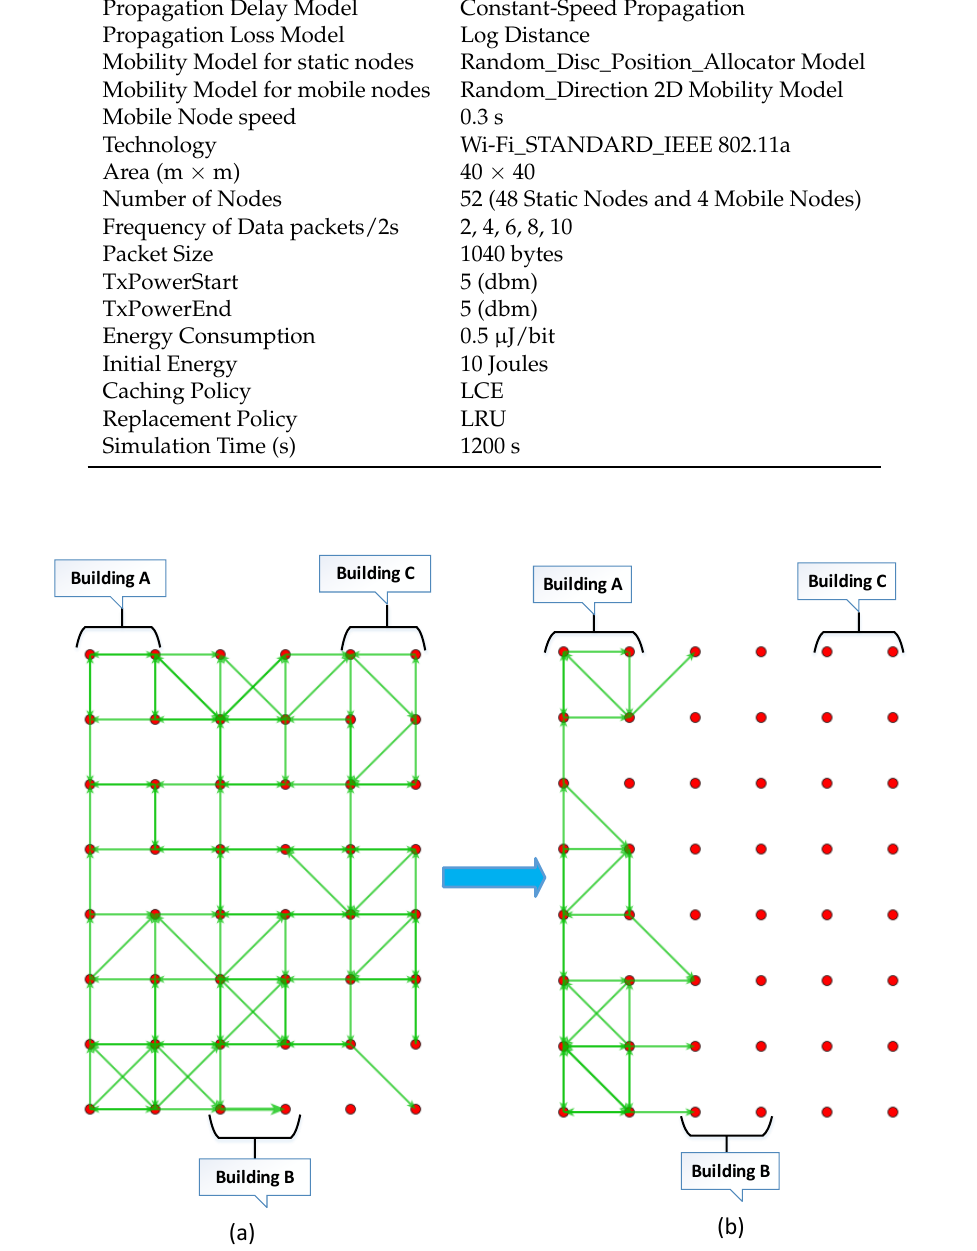
Figure 6. Simulation Scenario for smart building: ( a ) Simulation scenario with NDN-DISCA, ( b ) Simulation scenario with proposed scheme